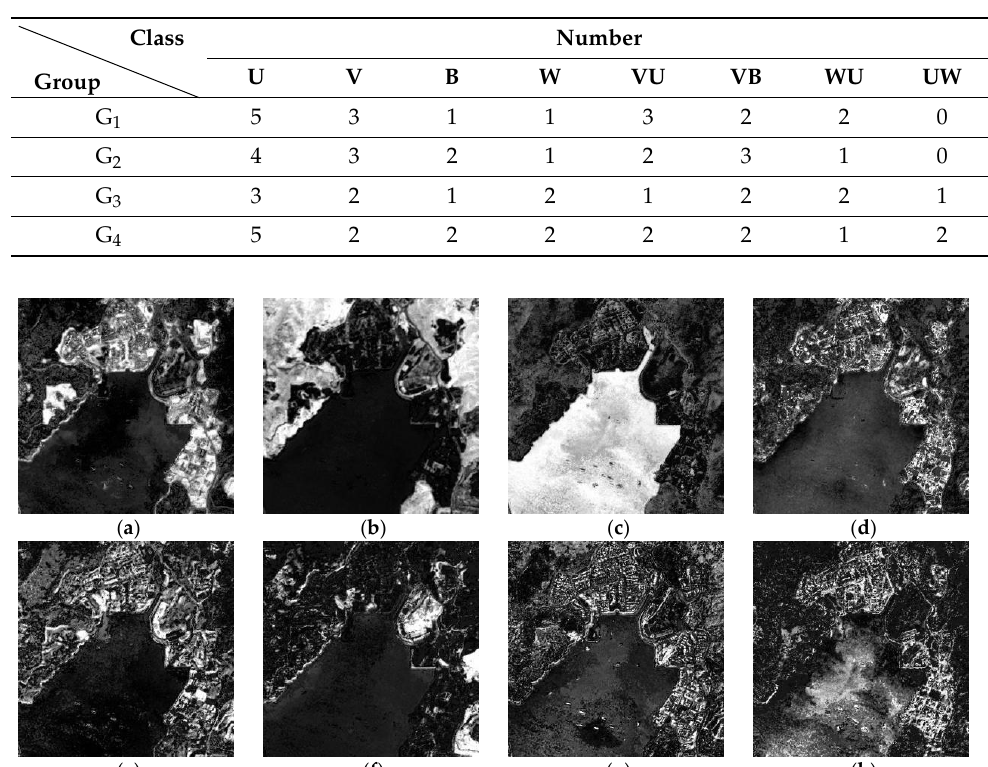
Figure 8. The abundances in the entire images: ( a ) urban (U), ( b ) vegetation (V), ( c ) water (W), ( d ) bare soil (B), ( e ) vegetation–urban (VU), ( f ) vegetation–bare soil (VB), ( g ) water–urban (WU) and ( h ) urban–water